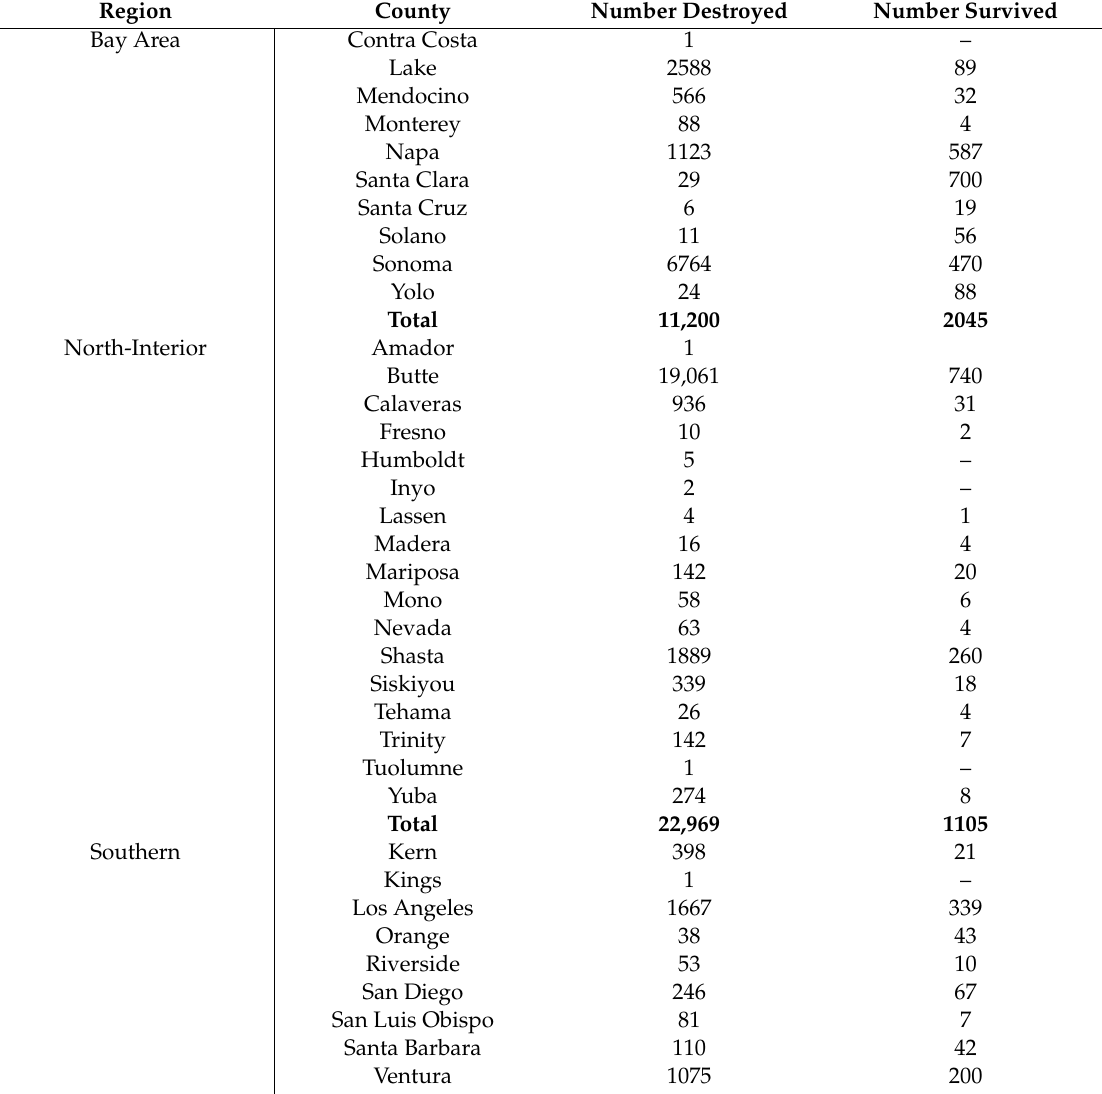
Table 1. Number of destroyed and survived structures from 2013–2018 by county and region in California. Dash marks indicate no structure outcomes recorded. The bold totals report the sums of destroyed and survived structures for each